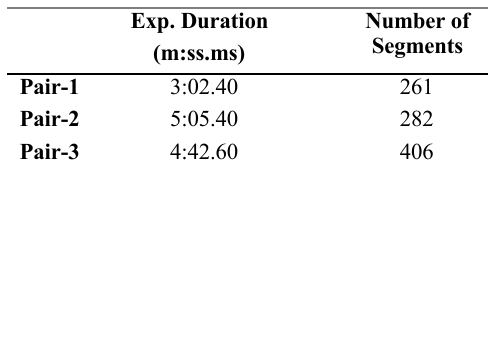
Table 2. Audio length and number of segments for each